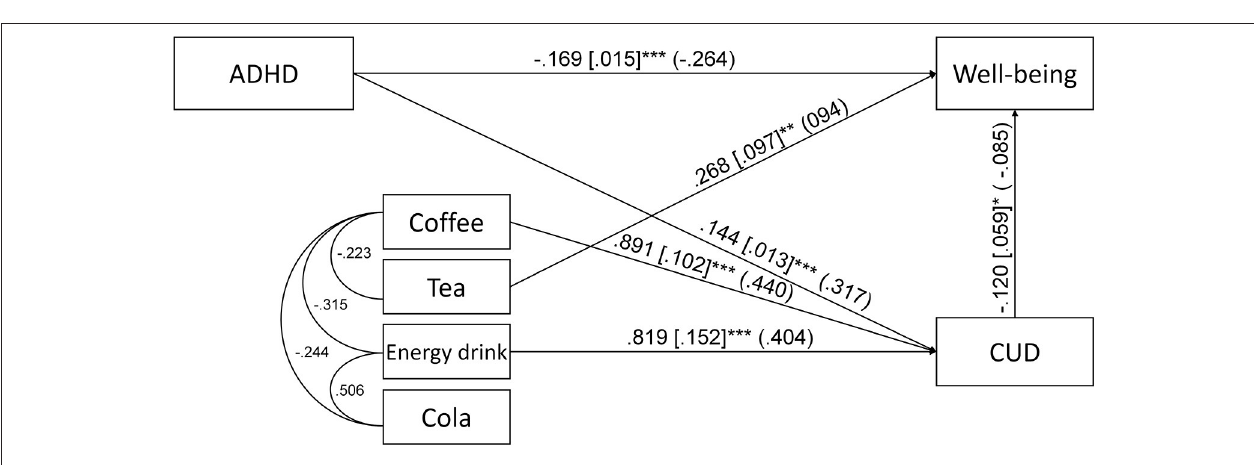
FIGURE 3 | Path analysis for the association of ADHD symptoms, coffee, tea, energy drink and cola consumption, caffeine use disorder symptoms (CUD) and well-being. Unstandardized regression coefficients, their standard errors (in brackets) and standardized coefficients (in parentheses) are presented in the figure. Only the significant ( p < 0.05) direct paths and error covariances are presented * p < 0.05; ** p < 0.01; *** p < 0.001. positive association with perceived psychological